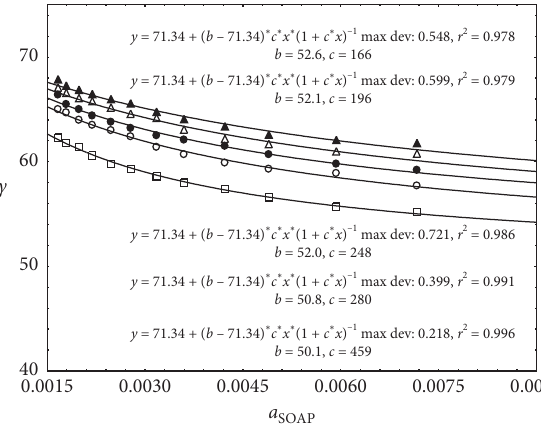
Figure 18: Variation of c with a : closed triangles (LFBY), triangles (NM), closed circles (OKT), circles (LRL), and squares (LX); solid soap lines represent the model. Table 4: Slopes, critical micelle concentration (CMC), maximum surface excess concentration ( Γ